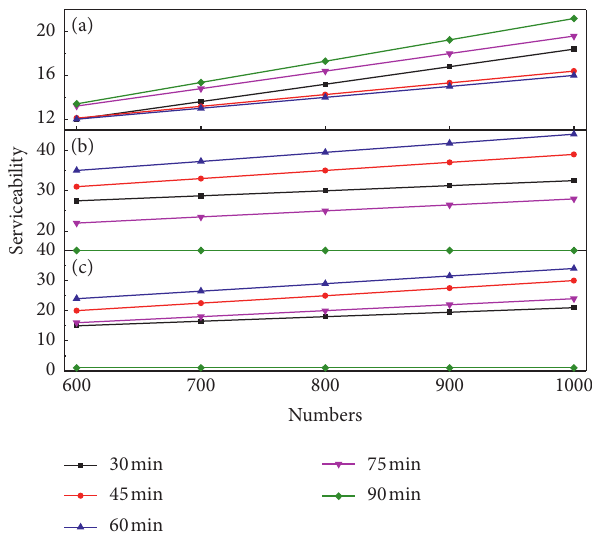
Figure 6: Serviceability conditions.